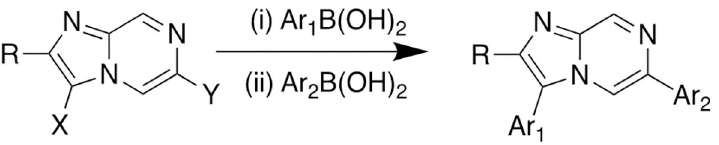
Fig 1. General scheme for the synthesis of final compounds. X = I (or Br), Y = Br (or I).